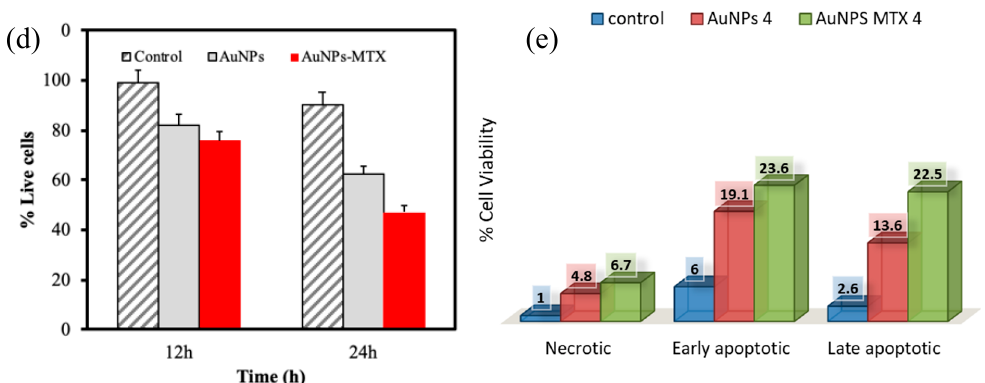
Figure 10. Flow cytometric analysis to determine death modes of cancer cells to HTC-116. The percentage of necrotic and apoptotic HTC-116 cells ( a ) Control ( b ) AuNPs and ( c ) AuNP–MTX400. ( d ) Comparison of time response to equal doses of AuNPs and AuNP–MTX400. ( e ) Representative percentage of necrotic and apoptotic AuNPs and AuNP–MTX400.